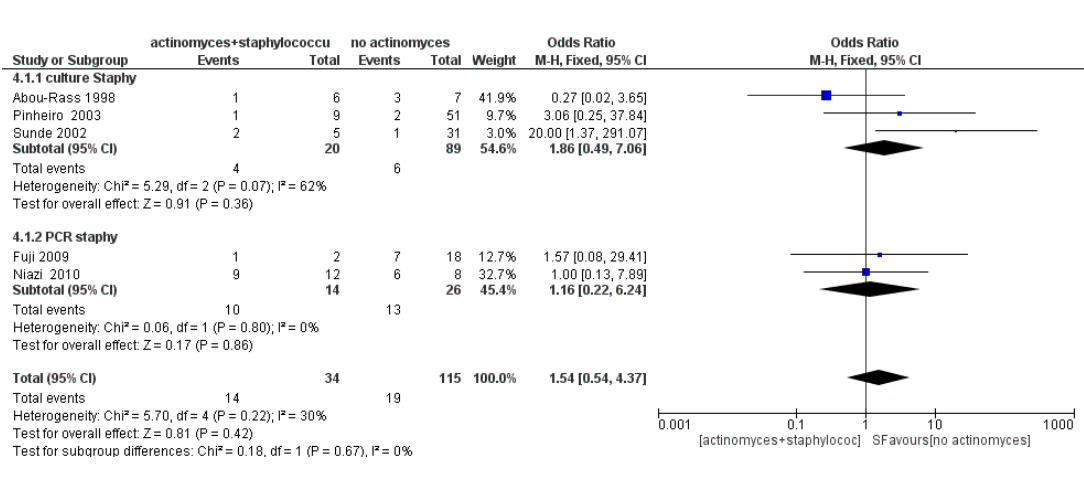
Figure 10. Forest plot of the fixed effects model of the meta-analysis of sub-group Peptostreptococci. Sub-group culture (OR = 4.03, 95% CI: [1.85, 8.79]), sub-group PCR (OR = 0.29, 95% CI: [0.05, 1.58]).